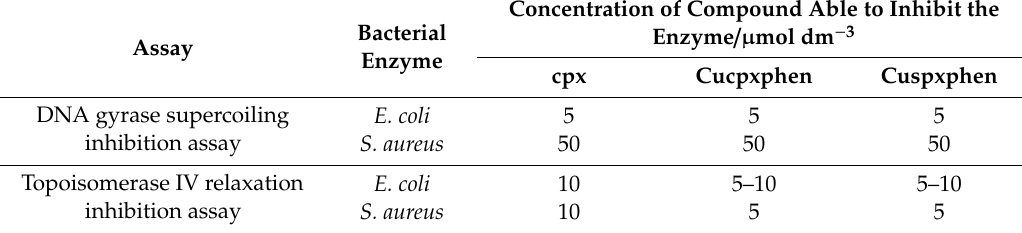
Table 6. Concentrations of cpx, Cucpxphen and Cuspxphen able to inhibit the activity of DNA gyrase and topoisomerase IV of E. coli and S. aureus . The values presented were obtained from at least three independent